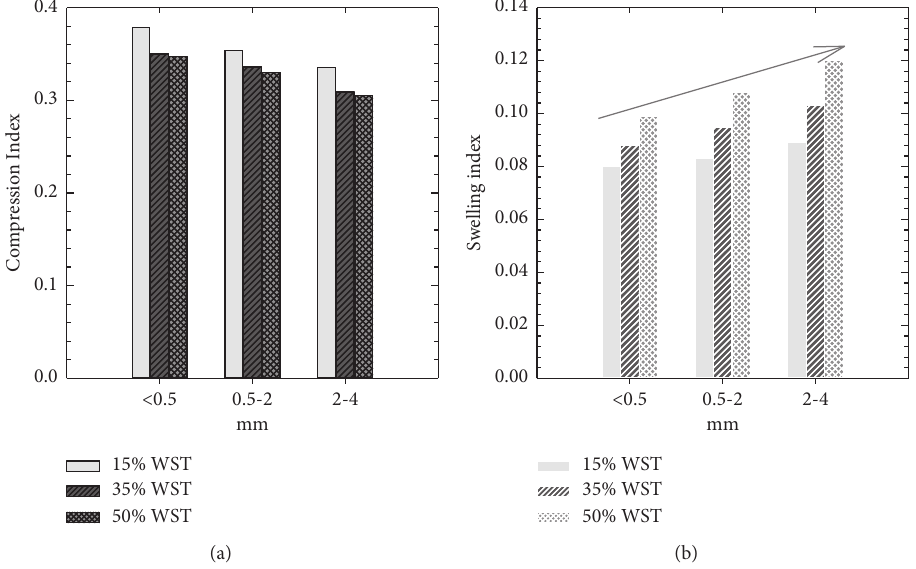
Figure 5: (a) Compression index and (b) swelling index of WST-reinforced Lianyungang marine soil.